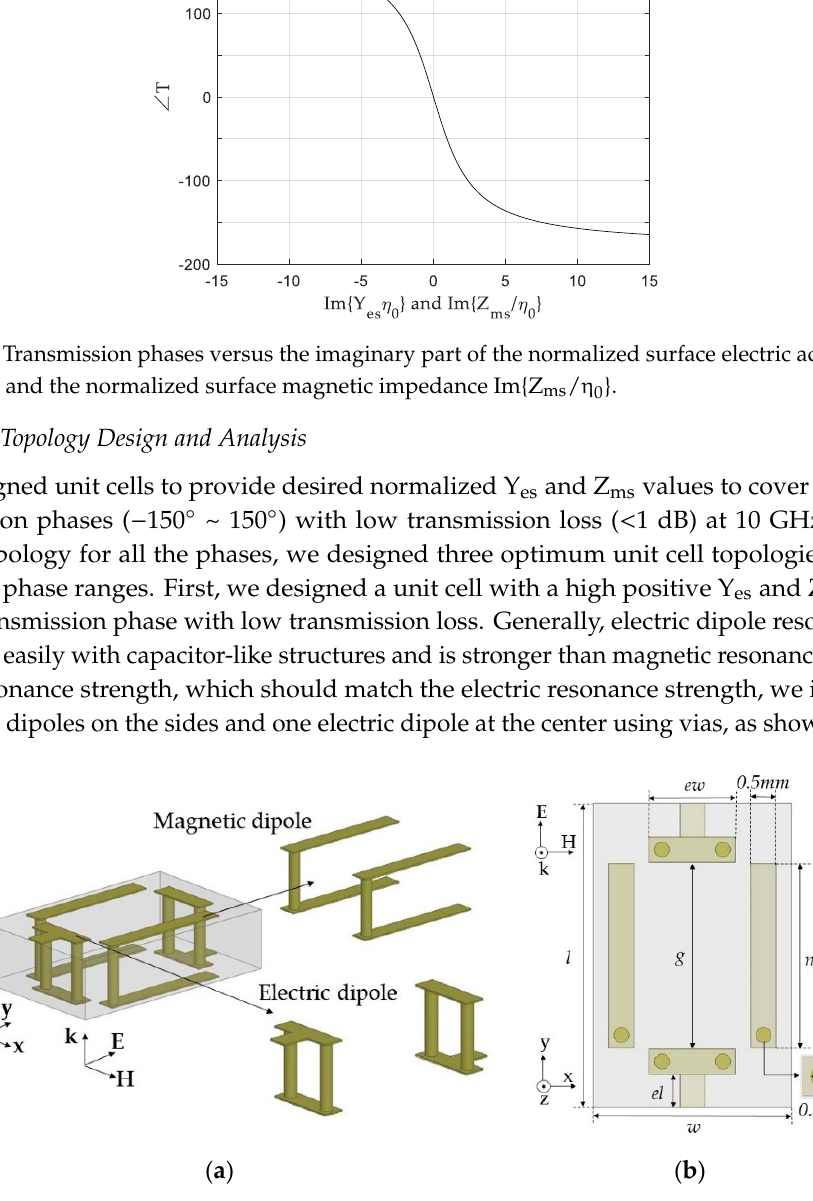
Figure 2. Electric and magnetic dipole in topology 1 from the ( a ) side–side view and ( b ) top view.